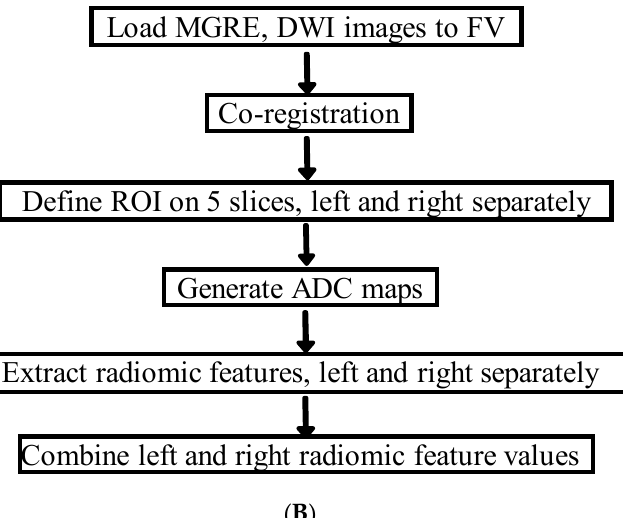
Figure 1. ( A ) High-level descriptions of the steps involved in the image analysis pipeline. The dotted lines indicate possible future extension. ( B ) A flow chart of kidney segmentation, quantitative analysis, and feature extraction using FireVoxel.